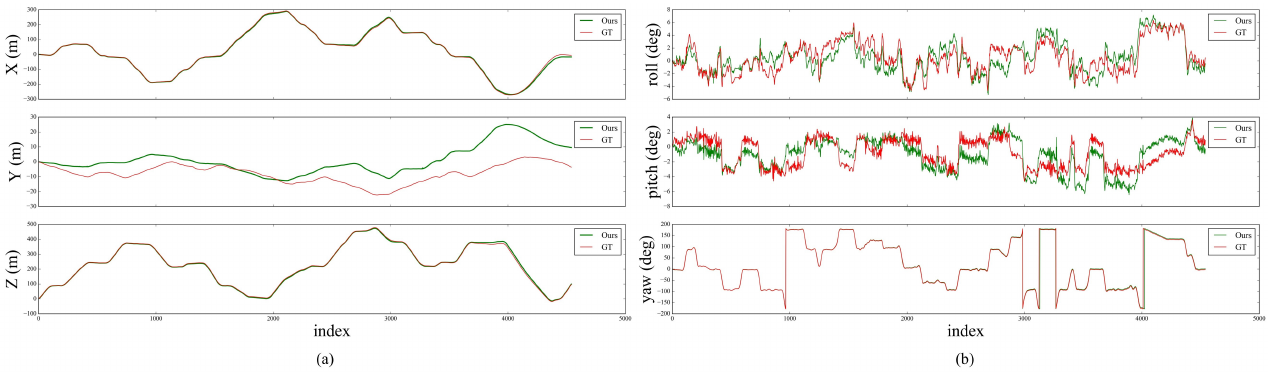
Figure 14. Change of position and orientation compared with ground truth on the KITTI sequence 00. The trajectories have been transformed to the coordinate system of Camera 0 through extrinsic parameters (xyz → zxy). ( a ) represents the position change of the camera. ( b ) represents the change of the Euler angle of the